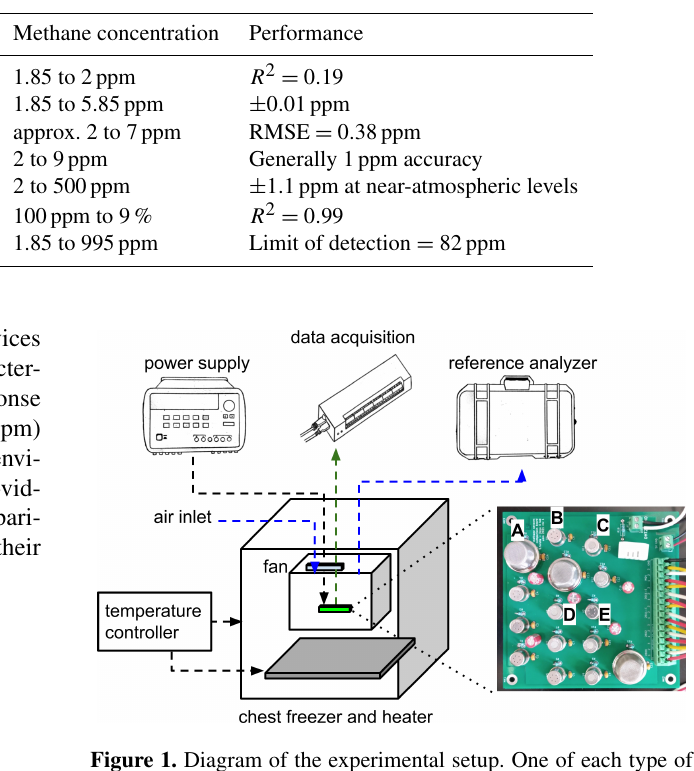
Table 1. Summary of results of selected studies.